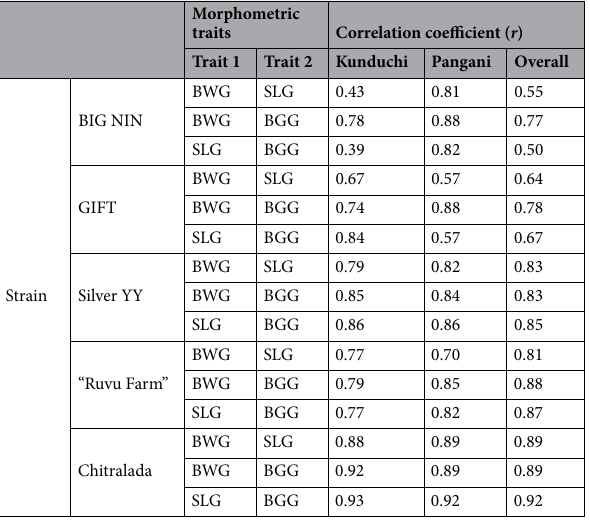
Table 4. Correlation coefficient among the morphometric traits of five Nile tilapia strains reared at Kunduchi and Pangani. Morphometric traits: Body weight gain (BWG); Standard length gain (SLG); Body girth gain